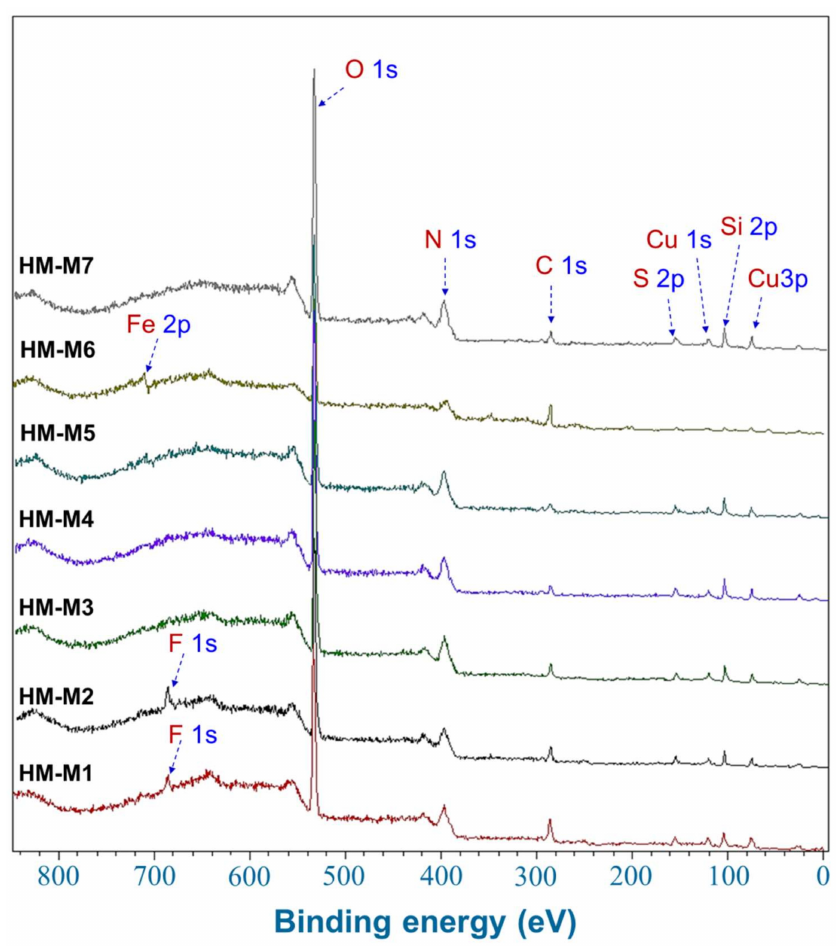
Figure 6. Wide scan X-ray photoelectron spectroscopic (XPS) spectra of the seven humins